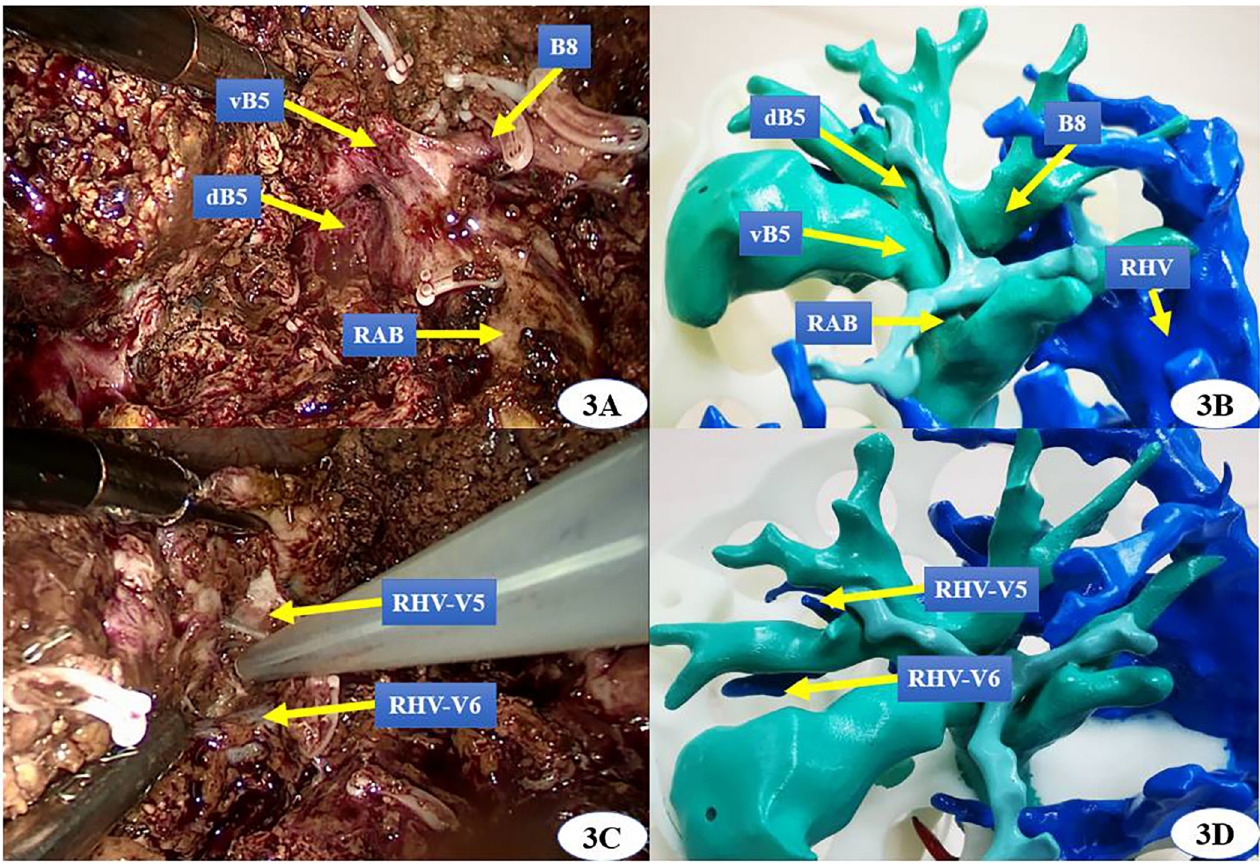
Fig 3. 3D printing technology was applied in laparoscopic V segmentectomy real-timely. (vB5: the ventral bile duct of segment 5, dB5: the dorsal bile duct of segment 5, B8: the bile duct of segment 8, RAB: right anterior bile duct, RHV: right hepatic vein, RHV-V5: The venous reflux of hepatic segment 5 to RHV, RHV-V6: The venous reflux of hepatic segment 6 to